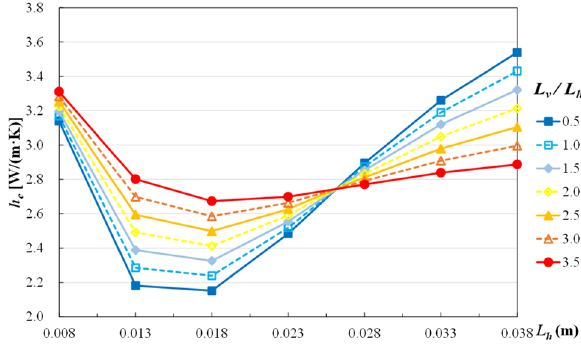
Figure 3. Relationship between cavity h c and width.